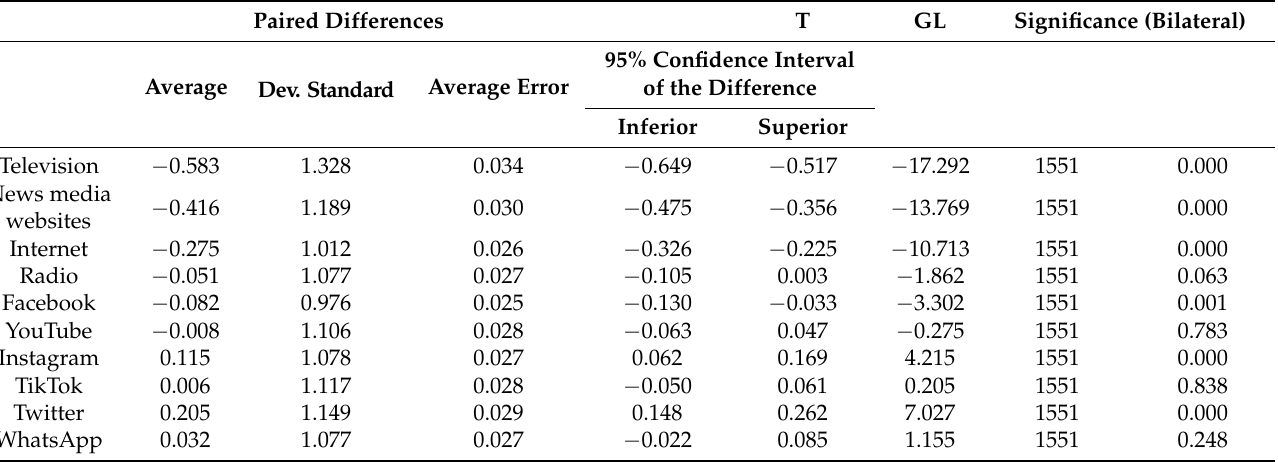
Table 2. “Student t” test for related samples in the media to analyze their increase at the beginning of and during COVID-19.